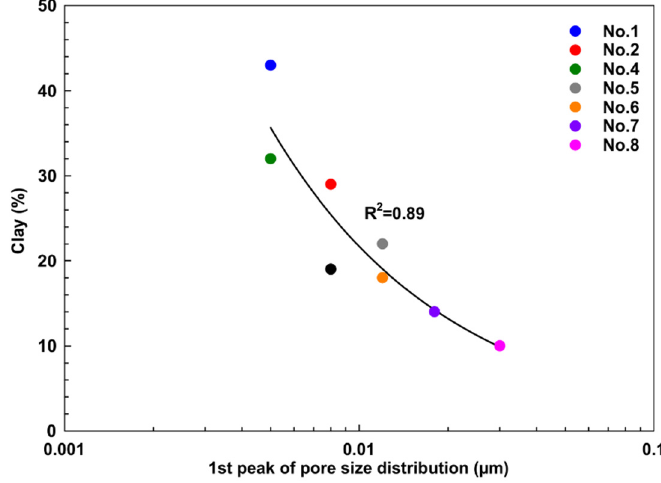
Figure 17. Clay content-small pore peak relationship of slurry samples.